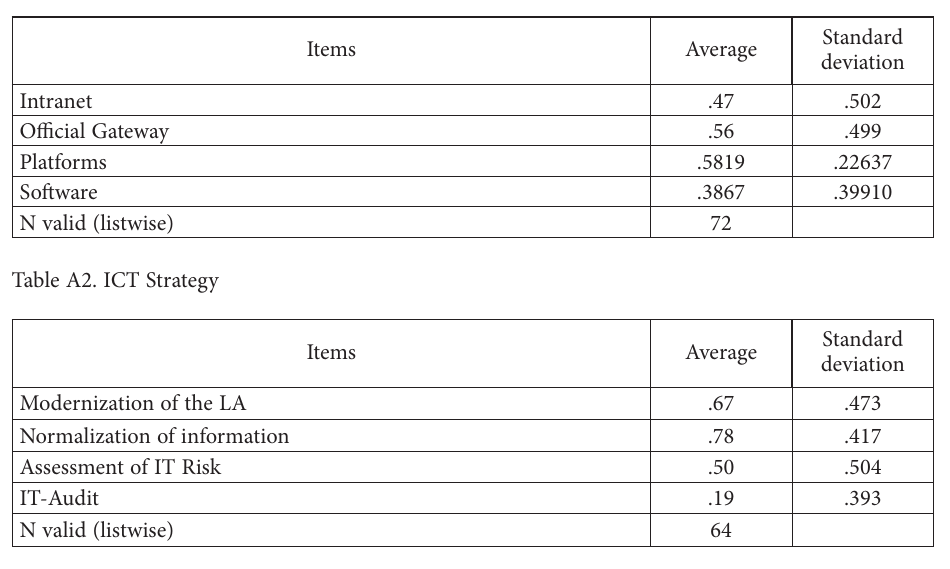
Table A1. Technology infrastructure